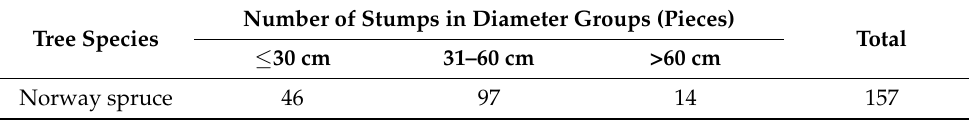
Table 2. Numbers of stumps in diameter groups on the site of LZ Boub í n, Netolice. Number of Stumps in Diameter Groups (Pieces) Tree Species